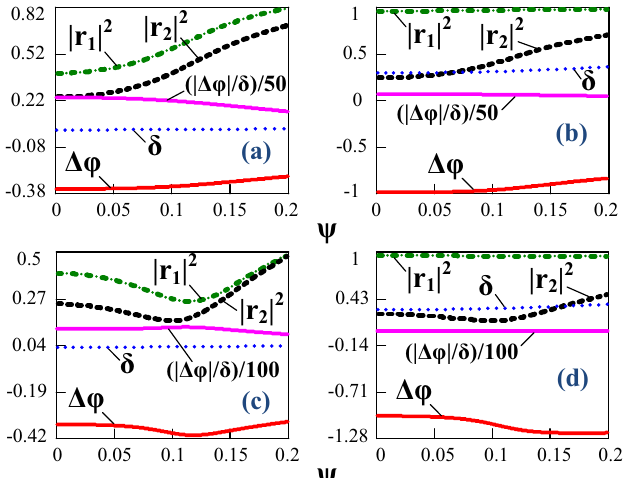
Fig. 6. Dependences of phase ( D ’ , d , | D ’ |/ d ) and energetic (| r 1,2 | 2 ) re fl ection characteristics of the multilayers on inci- dence angle c for the TE (a, b) and TM (c, d) polarized exciting wave. The values of parameters are: d 2 = 4 nm (a, c), 40 nm (b, d). The values of parameters for all the graphs are: l = 550 nm, d 1,3,4 = 0, e b = 0.1 + 0.1 i , m b = 1, the main layer material is silver. Values of c (as D ’ , d ) are given in the relative units of radians / p .